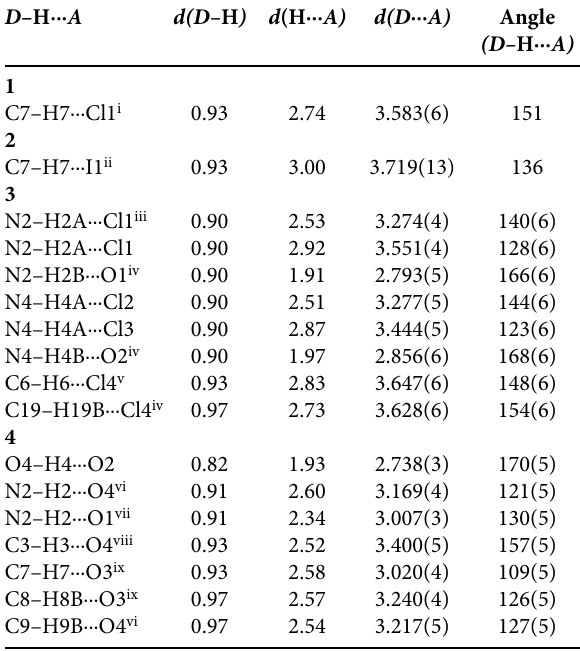
Table 3. Hydrogen bond distances (Å) and bond angles (°) for the complexes